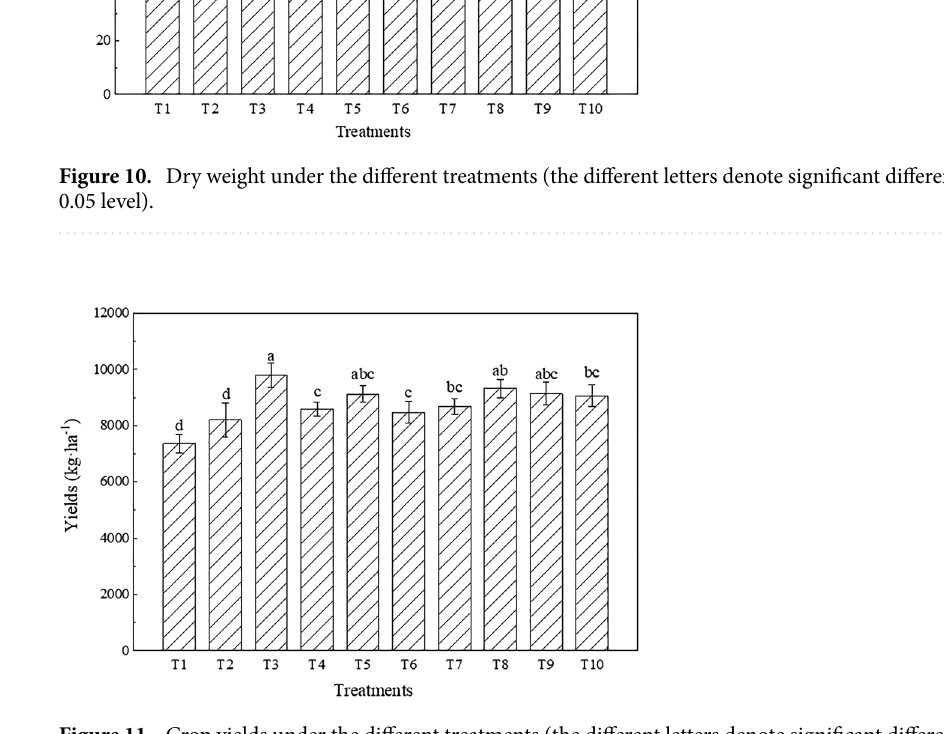
Figure 11. Crop yields under the different treatments (the different letters denote significant differences at the 0.05